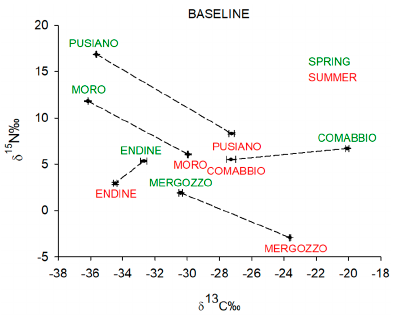
Figure 2. Carbon and nitrogen isotopic fingerprint of the pelagic baselines ( Daphnia ) in spring (green) and summer (red) in all lakes.